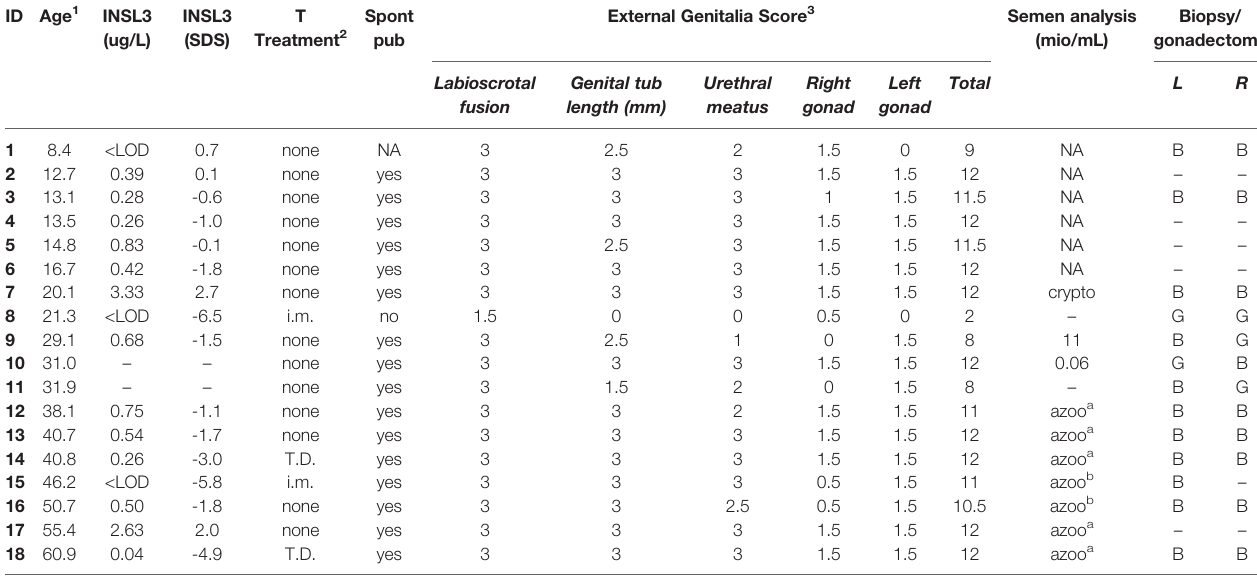
TABLE 1 | Serum concentrations of insulin-like factor 3 (INSL3) and clinical fi ndings in 18 males with 45,X/46,XY mosaicism. ID Age 1 INSL3 INSL3 (ug/L)